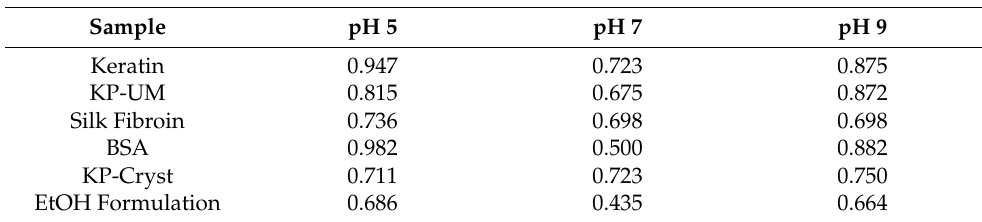
Table 2. Perming efficiency ratios of the hair treated with keratin, KP-UM, silk fibroin, BSA and KP-Cryst proteins prepared in phosphate buffer at different pH values. The ratios were calculated between the perming efficiency results of the hair treated with the protein formulations and the hair chemically